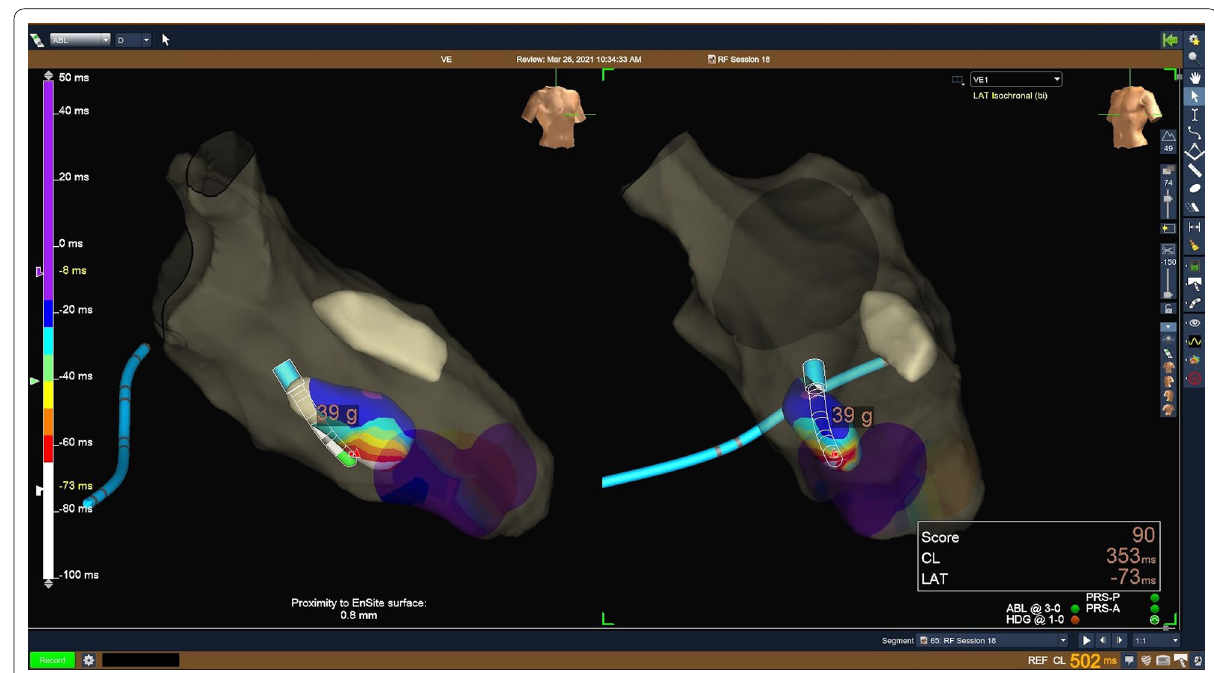
Fig. 5 Three-dimensional electro-anatomic map of the left ventricle seen in the right anterior oblique (left) and the caudal (right) projections, illustrating one of several sites of origin of ectopy targeted with ablation. The catheter tip (green) is shown at the site of earliest activation (white and red area) of a frequent